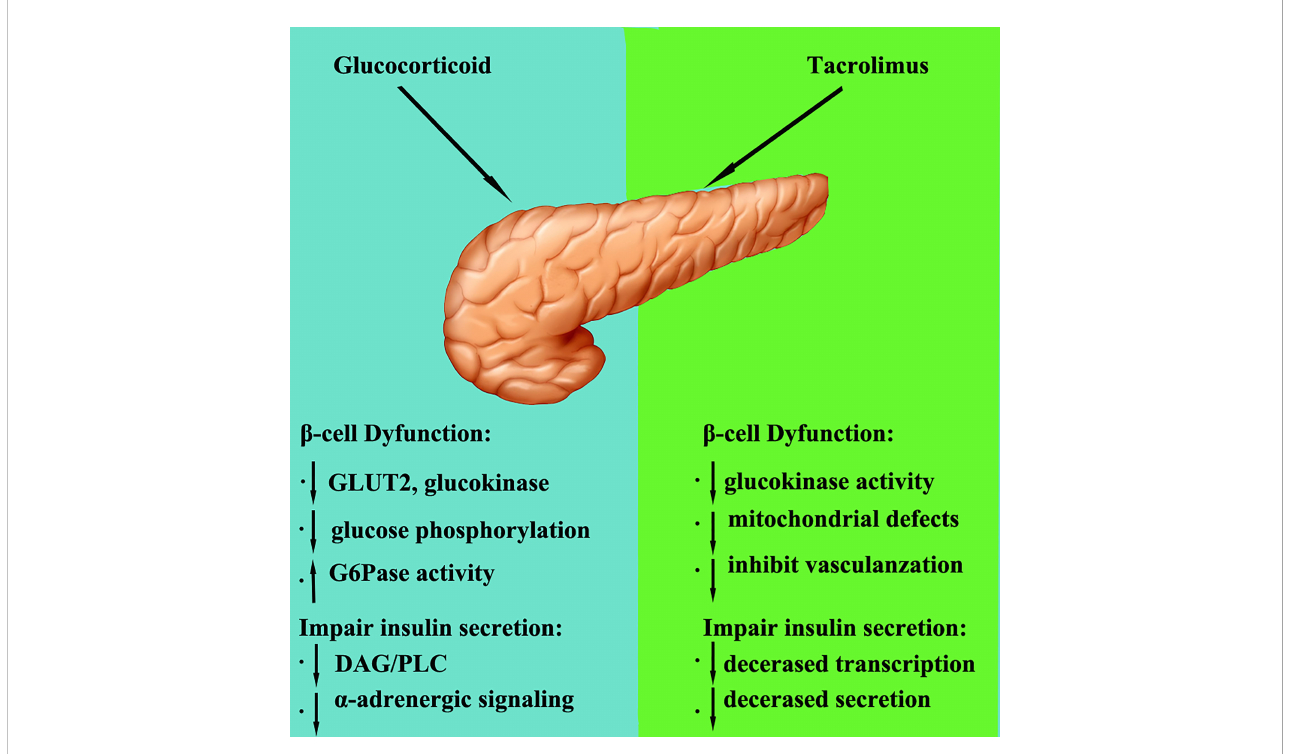
FIGURE 1 The mechanism of glucocorticoid and tacrolimus in regulating pancreatic glucose